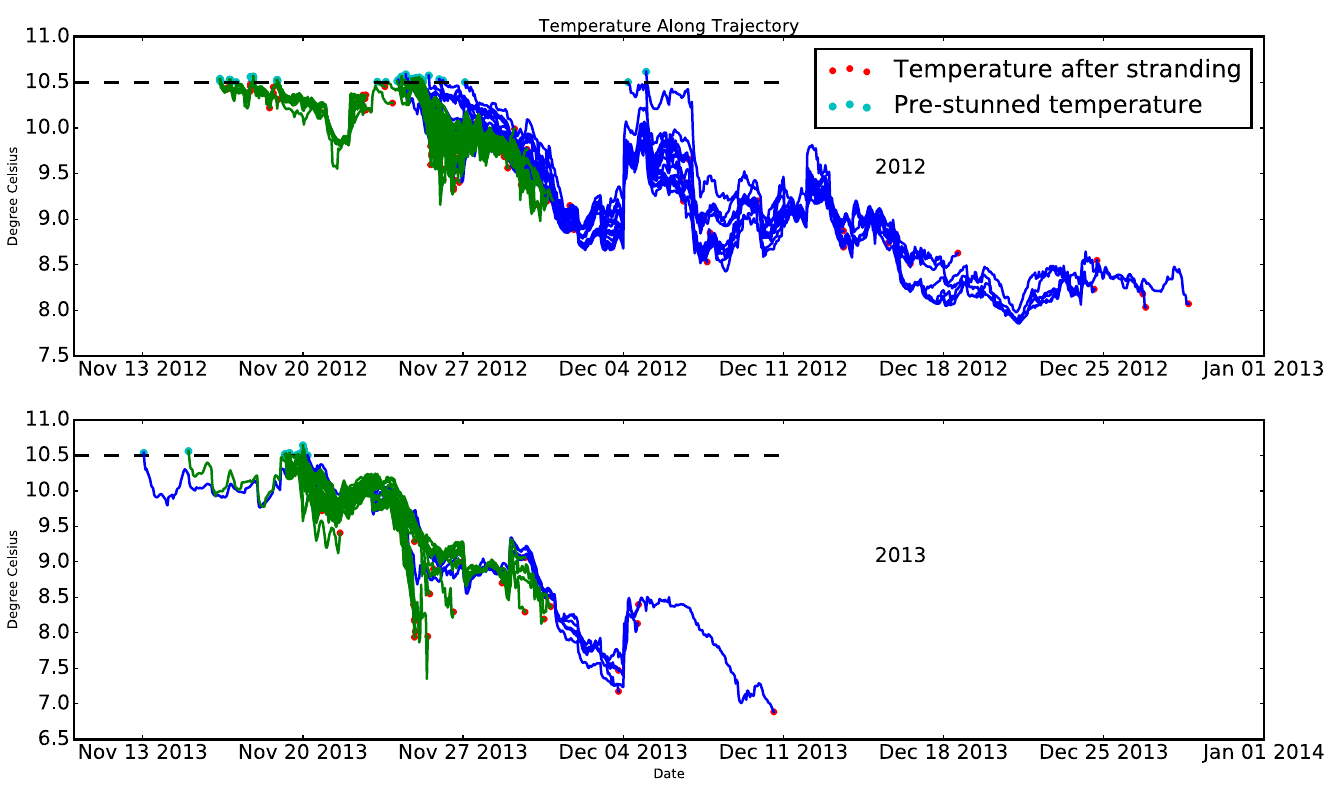
Fig 13. Modelled temperature of backtracked surface particles in 2012 (top panel) and 2013 (bottom panel).